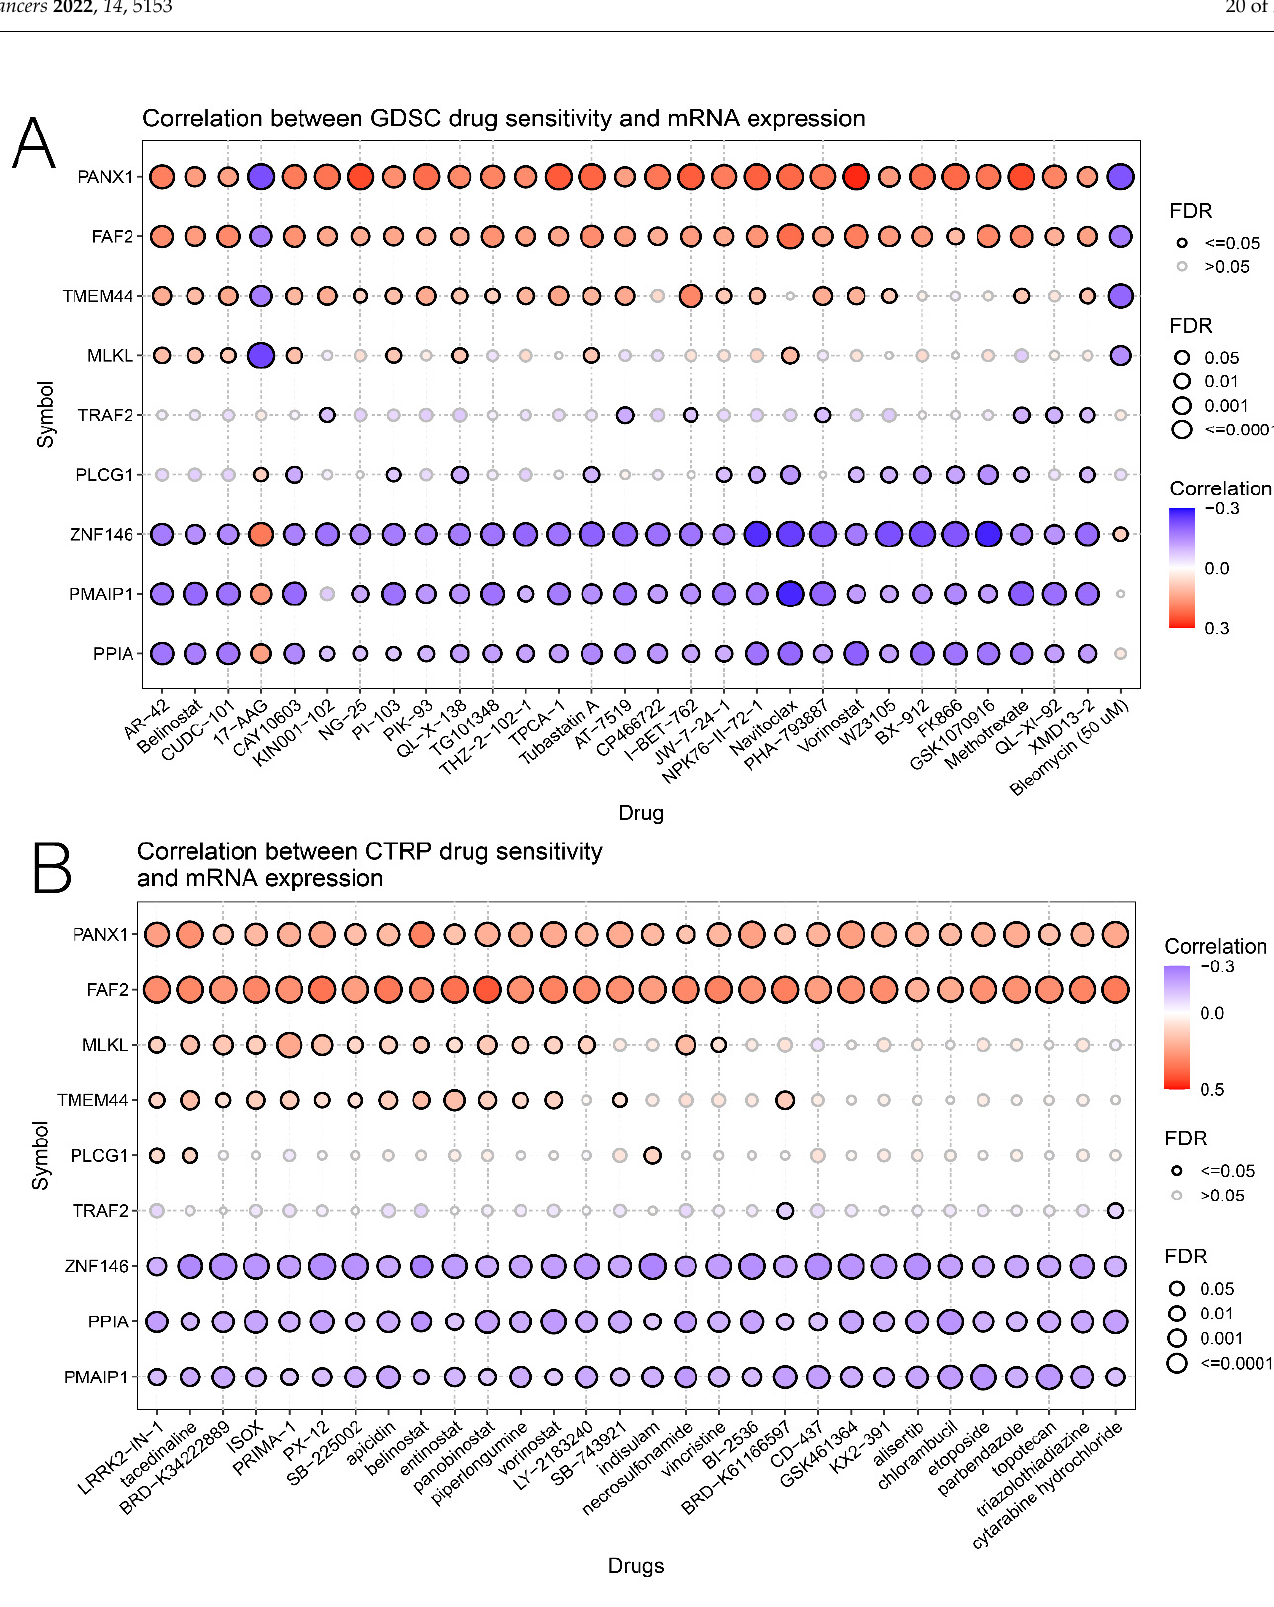
Figure 13. ( A , B ) Relationship between nine DENRGs in the prognostic model and multiple chemotherapeutic drugs in two drug sensitivity databases, CTRP and GDSC.